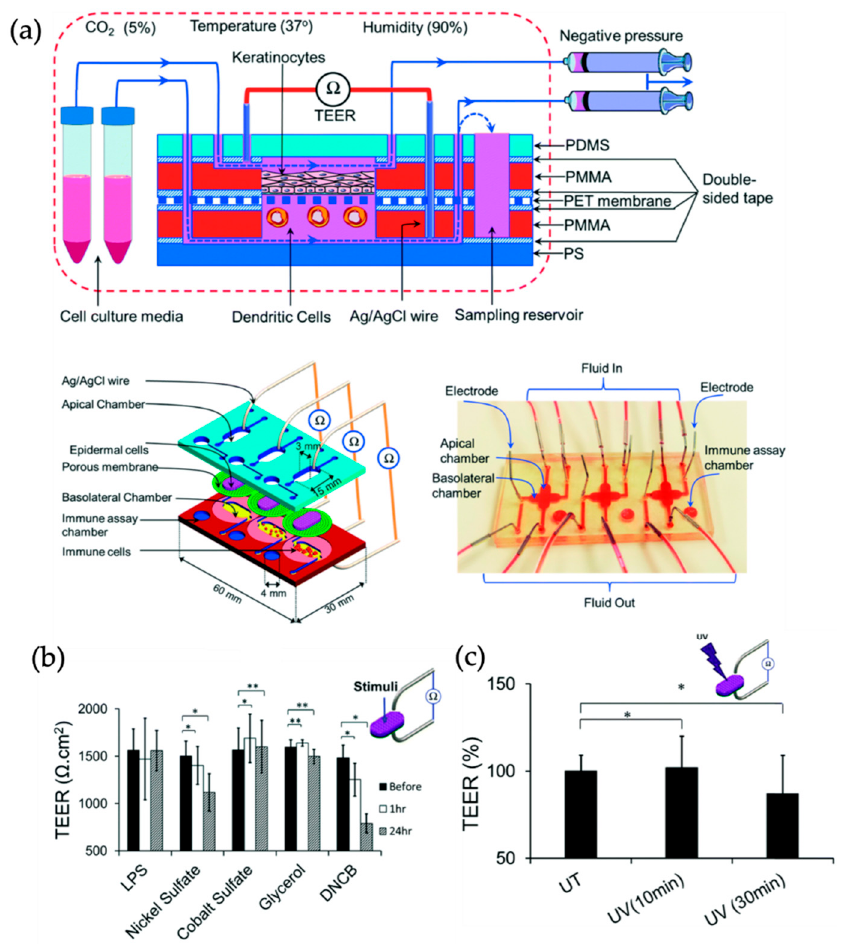
Figure 5. ( a ) Schematic cross-sectional sketch of the cell culture device with the perfusion setup as well as 3D schematic view of three parallel cell culture chambers including electrodes for TEER measurements and image of the fabricated chip. ( b ) TEER significantly decreases after 24 h of incubation with nickel sulfate while no obvious change is detectable after treatment with LPS, cobalt sulfate, or glycerol (* p < 0.05, ** p < 0.1). ( c ) The TEER value decreased to 82% of its original value upon UV irradiation. (Adapted from [47] with permission from The Royal Society of